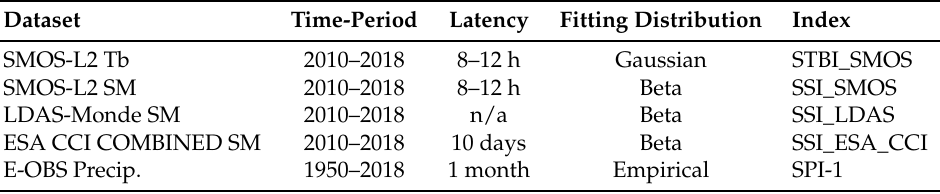
Table 1. Overview of drought indices. Baseline climatology, availability, PDF used for fitting and the resulting index